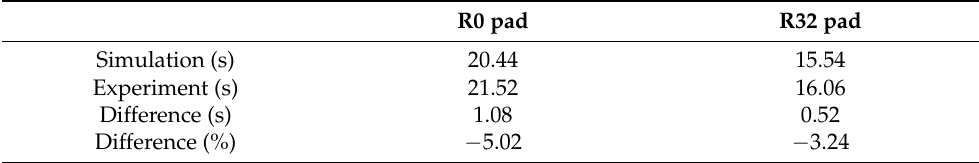
Table 4. Comparison of simulated and measured slurry saturation time of 100 mm wafer